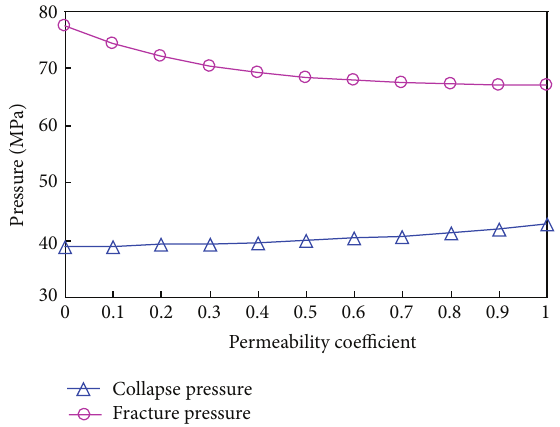
Figure 22: Variation of collapse pressure and fracture pressure with permeability.